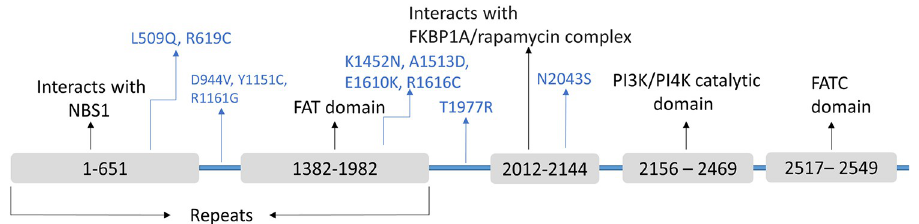
Fig 5. Domains and interaction sites within the mTOR protein. The positions of the final 11 nsSNPs are shown within mTOR protein with respect to the NBS1 interacting domain, FAT domain, PI3K/PI4K catalytic domain, and FATC domain. The domains are shown in grey horizontal bars and the nsSNPs are depicted by blue arrows. The exons (58 exons) are shown by green vertical bars while the introns are shown by green horizontal lines. The scaling of the exon positions and the domains is